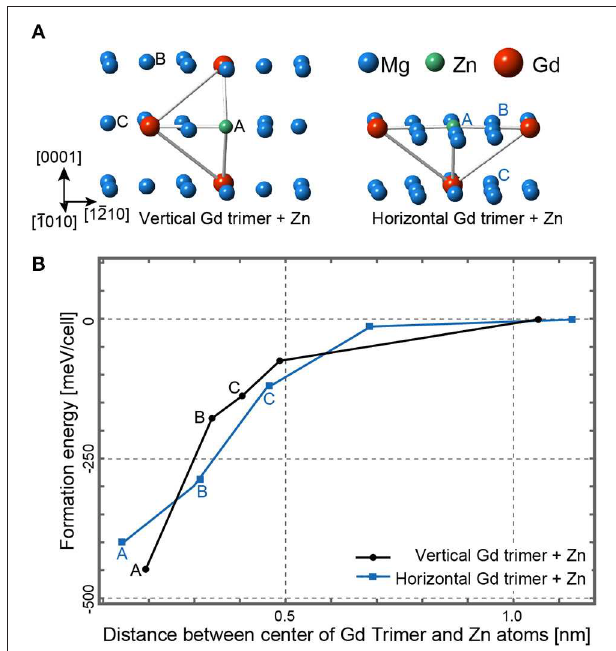
FIGURE 5 | (A) First-principles calculations of a single Zn atom effect for the Gd trimmers, T V, and T H , embedded in the hcp -Mg structure. Calculations were made with a hcp -base 5 × 5 × 4 supercell containing 200 atoms. Atom positions used for the Zn atoms are denoted by (left) black and (right) blue capital letters, respectively. (B) Calculated formation energies of the Zn-containing Gd trimmers, black and blue lines correspond to T V and T H , respectively. The capital letters represent the Zn positions in accordance with (A) . The origin of the formation energy is set to the one when the Zn atom is placed sufficiently far from the Gd-timer centers in the super cell. Conditions for the computations are the same as those described in Figure 4